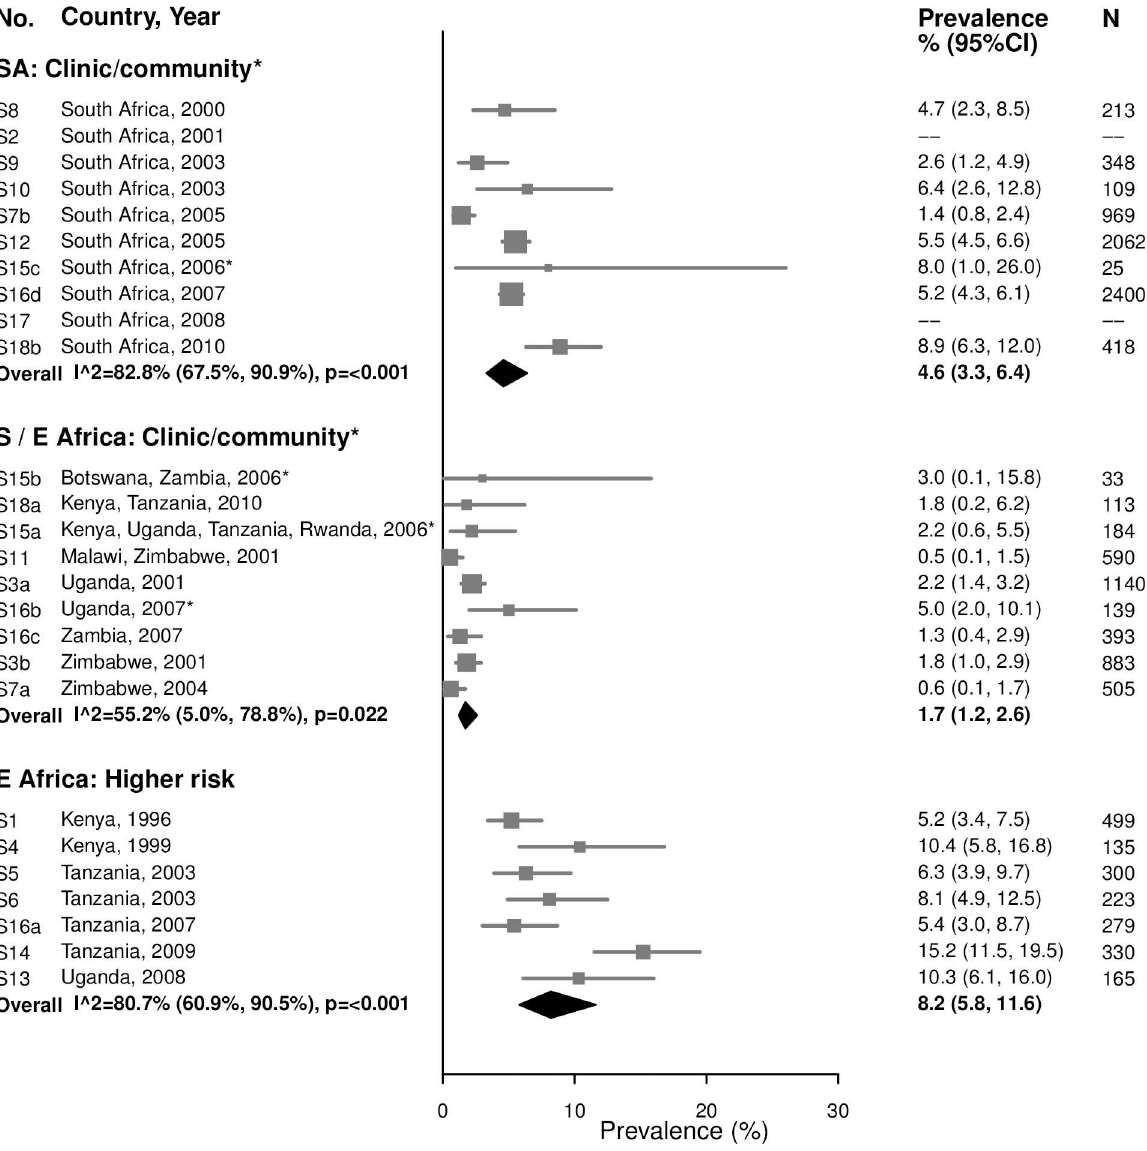
Fig 3. Gonorrhea prevalence among 15–24-year-olds. The area of the marker is proportional to the square root of the sample size. Studies with no estimate presented did not meet the inclusion criteria for this infection and age group. Year presented is the median year that baseline data were collected during the study. (cid:3) Includes studies of HIV-discordant couples. E Africa, Eastern Africa; SA, South Africa; S/E Africa, Southern and Eastern